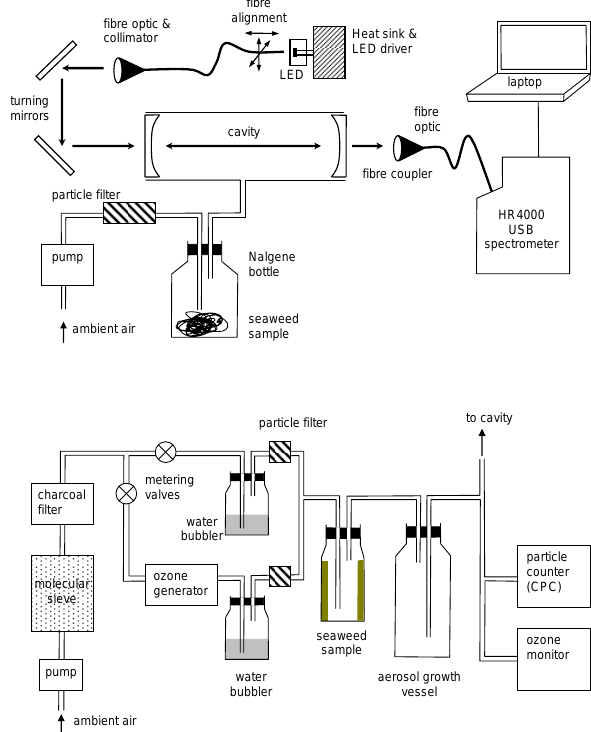
Fig. 1. Schematic diagrams of the apparatus and the BBCEAS spectrometer used in the seaweed incubation experiments (upper panel) and the flow reactor used in the Laminaria digitata stress experiments (lower panel).